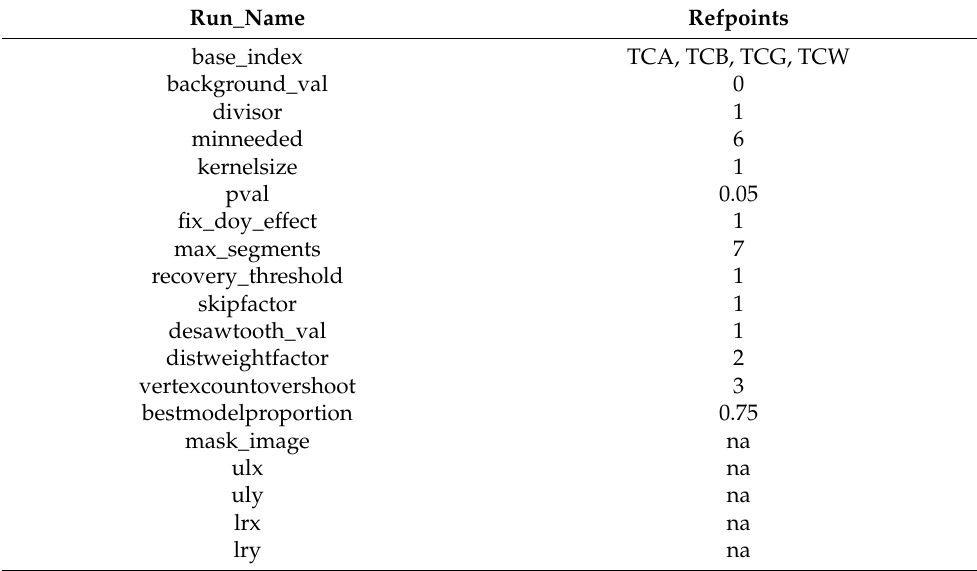
Table A2. LandTrendr segmentation parameters used in this study as default